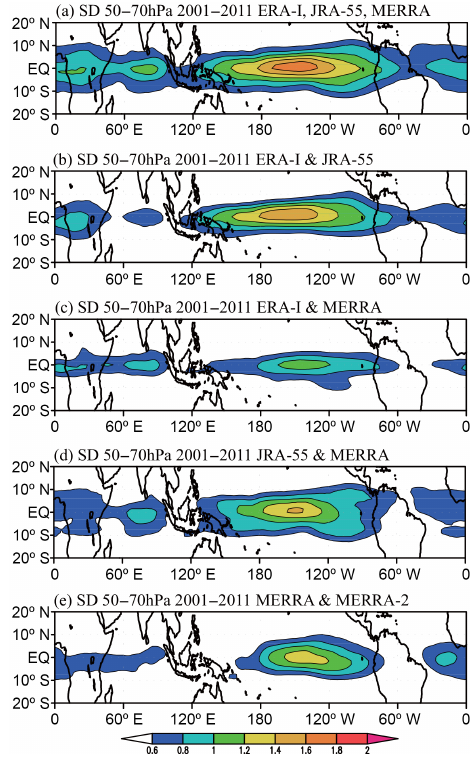
Figure 17. Same as Fig. 12c but for the standard deviation among (a) three reanalysis (ERA-I, JRA-55, and MERRA), (b) between ERA-I and JRA-55, (c) between ERA-I and MERRA, (d) between JRA-55 and MERRA, and (e) between MERRA and